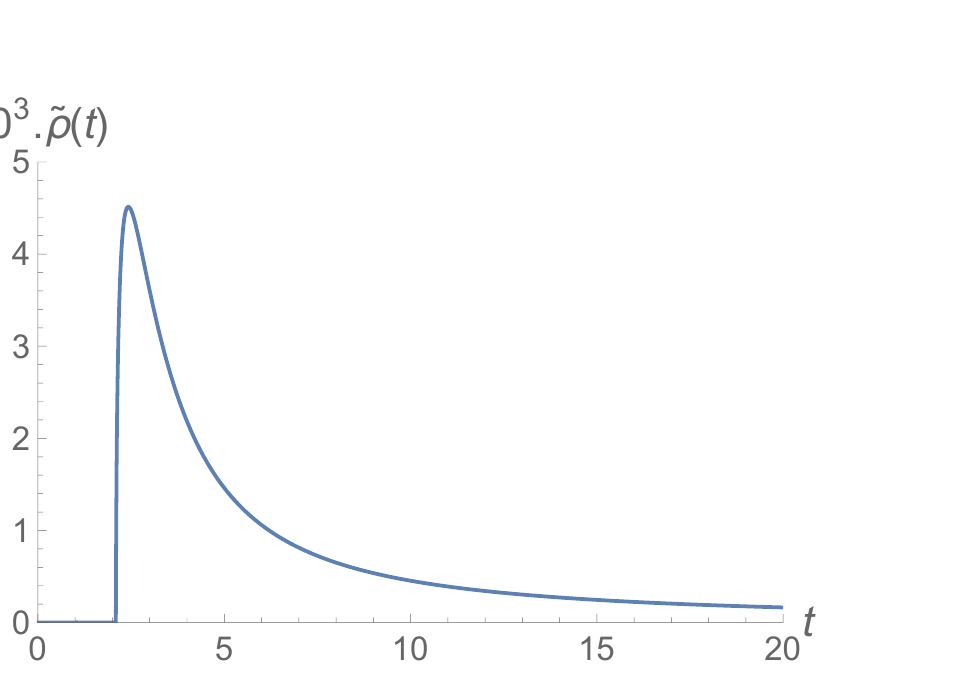
Figure 9 . Spectral function for the transverse part of the reduced photon